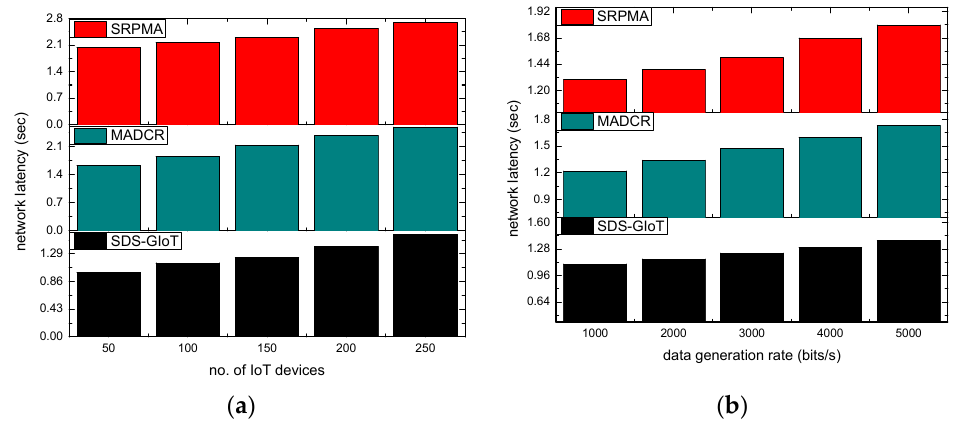
Figure 5. Scenarios for varying IoT devices and data generation rates in terms of network latency. ( a ) network latency and IoT devices. ( b ) network latency and data generation rates.